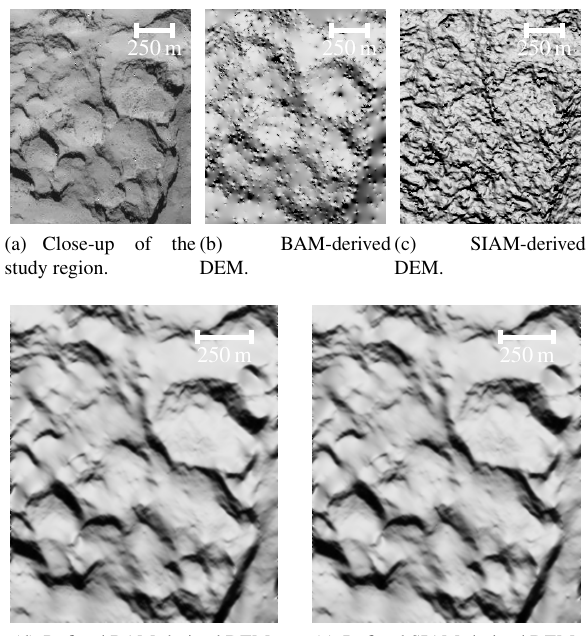
Figure 2: Region of interest. (a) A close-up view of the ROI (b) DEM obtained using BAM. (c) DEM obtained using SIAM. (d) SfS result using the BAM-derived DEM. (e) SfS result using the SIAM-derived